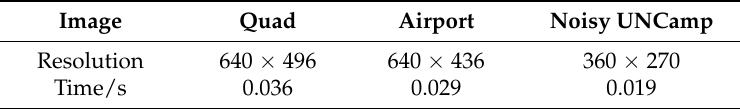
Table 1. The Calculation time of region segmentation method based on ROI.